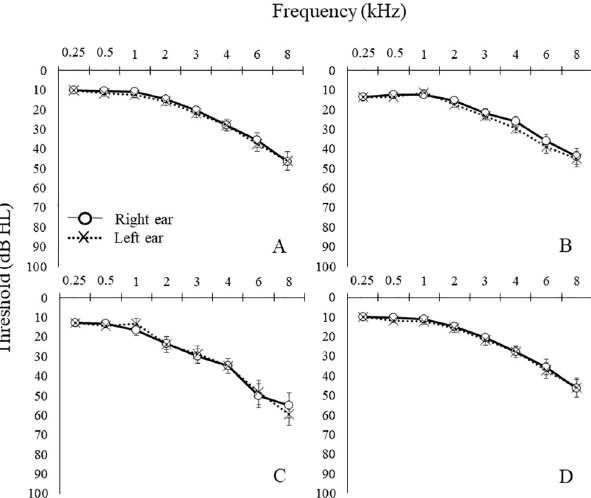
Fig 1. Mean pure-tone thresholds in dB HL for the group of older adults. (A) 60–69 years (n = 23), (B) 70–79 years (n = 31), (C) 80–89 years (n = 8) and (D) grand average (n = 62). Error bars are ± 1 SE from the mean. Conventional symbols are used to show data from the right and left ears.